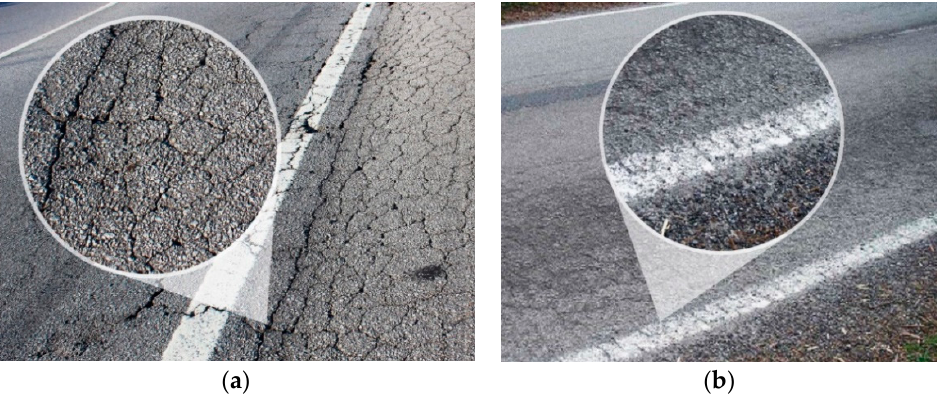
Figure 3. Examples of the distresses: ( a ) alligator cracking (ACR) and ( b ) raveling (R).